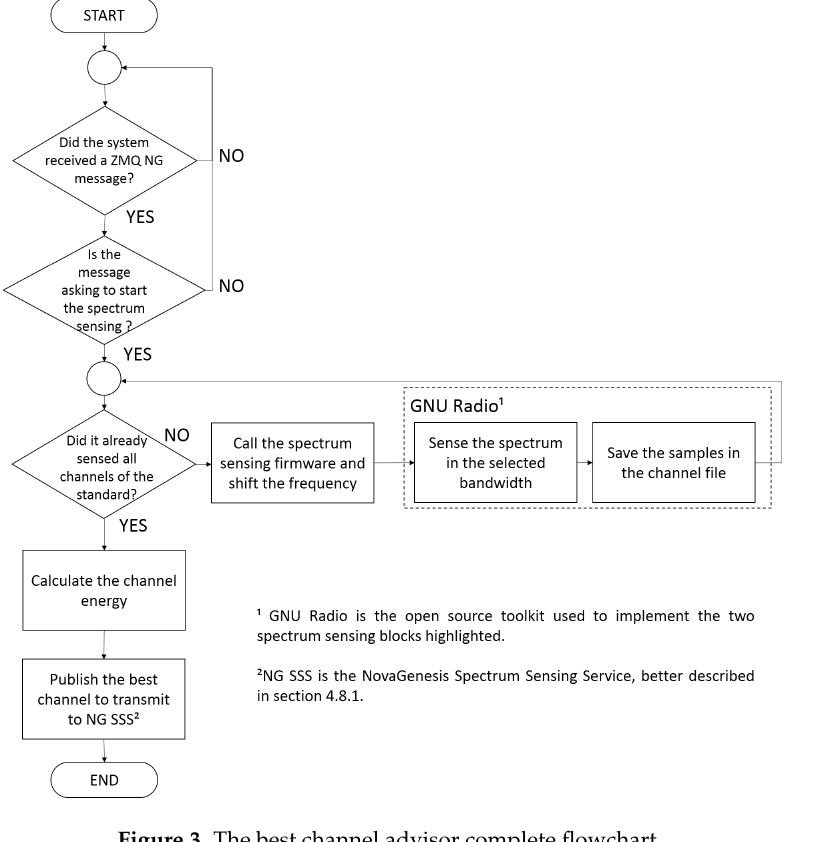
Figure 3. The best channel advisor complete flowchart.